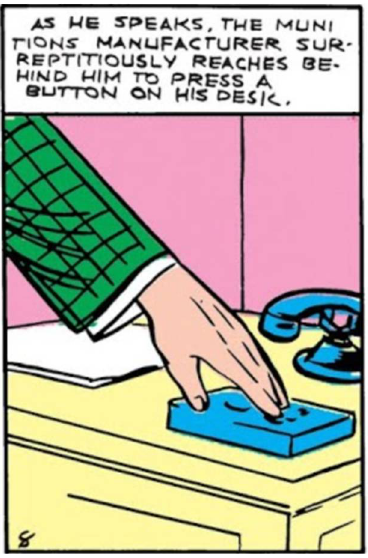
Figure 11. Joe Shuster, Three Armed Guards Running Away from Superman (panel No. 12), 1938. Siegel and Shuster (July 1938), “Superman”, Action Comics #2 (Siegel and Shuster 1938b, p. 23). © DC Comics.